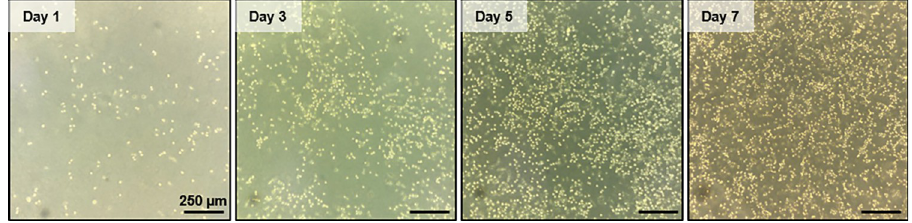
Fig 3. Proliferation and growth of 4T1 tumor cells in the HFSM device. Brightfield microscope images of 4T1 cells in the culture chamber over the course of a 7-day